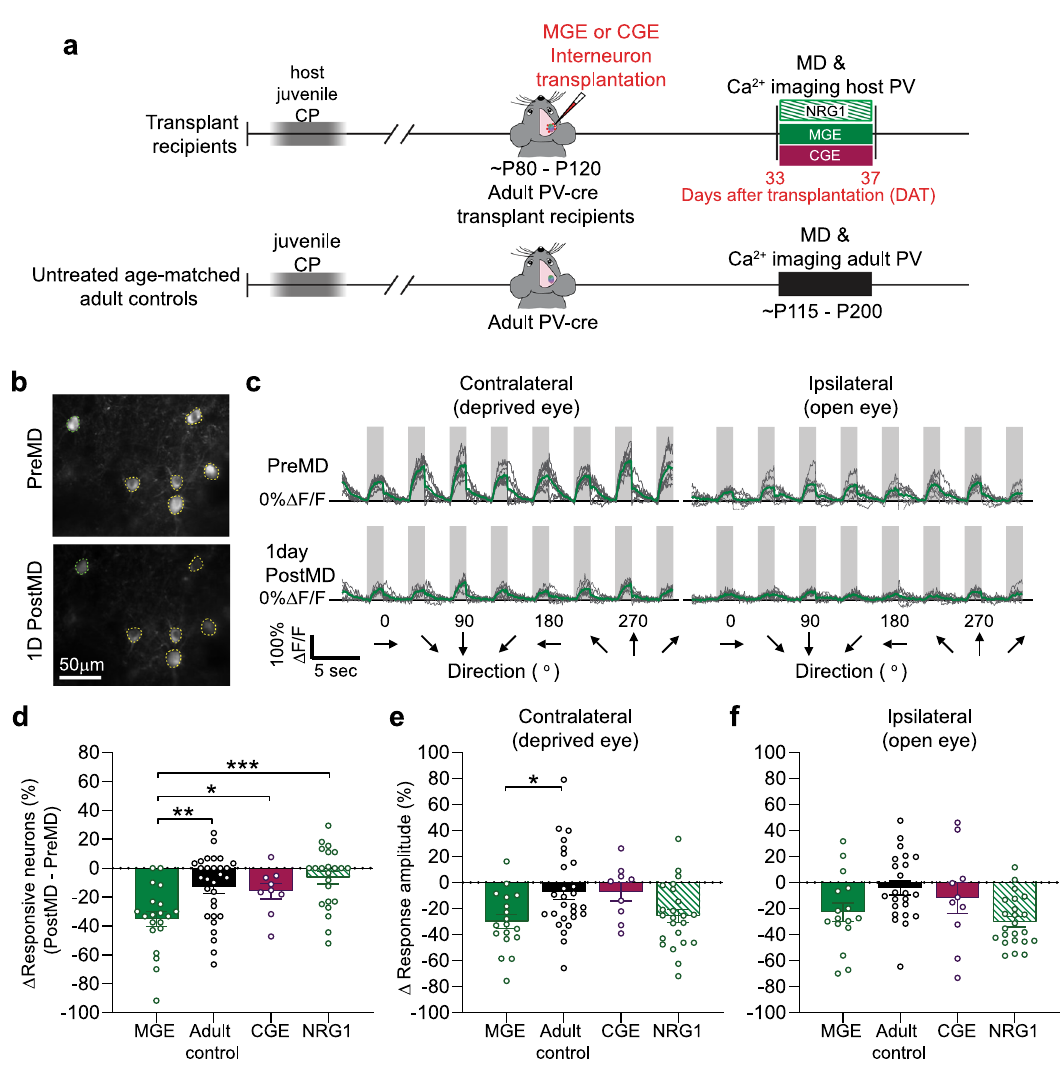
Fig. 4 Transplant-induced sensitivity of host PV interneurons to brief MD depends upon NRG1 signaling. a Experimental timeline. Top: calcium imaging of host PV interneurons in MGE transplant recipients (green, MGE), MGE recipients treated with NRG1 (dashed green, NRG1) or CGE transplant recipients (magenta, CGE) were performed at 33 – 35 days after transplantation. Bottom: imaging of PV interneurons in untreated adult control mice was performed around postnatal day (P) 115 (black, adult control). b In vivo image of GCaMP6s-labeled host PV interneurons in a MGE transplant recipient. Responsive cells are outlined in yellow and green. Scale bar = 50 µ m. In vivo Ca 2 + imaging of PV interneurons were performed independently in 25 mice (17 transplant recipients and 8 wild-type mice). c Visually evoked responses at the peak spatial frequency for the cell outlined in green in b . d 1D MD reduced the overall responsiveness of host PV interneurons in 35DAT transplant recipients (MGE: n = 20 fi elds from 6 mice; adult control: n = 30 fi elds from 8 mice; 35DAT CGE: n = 9 fi elds from 5 mice; NRG1: n = 23 fi elds from 6 mice; 35DAT MGE vs. adult control: ** p = 0.0054; 35DAT MGE vs. 35DAT CGE: * p = 0.048; 35DAT MGE vs. NRG1: *** p = 0.0004, Brown – Forsythe ANOVA followed by Dunnett ’ s T3 multiple comparisons test). e , f 1D MD resulted in a large reduction in the response amplitude of 35DAT host PV interneurons through both the deprived ( e ) and open eyes ( f ). However, exogenous NRG1 did not prevent the reduction in the response amplitude of host PV interneurons (Contra: 35DAT MGE, n = 18 fi elds from 6 mice; adult control, n = 27 fi elds from 8 mice; CGE, n = 9 fi elds from 5 mice; NRG1, n = 23 fi elds from 6 mice; 35DAT MGE vs. adult control, * p = 0.019; 35DAT MGE vs. 35DAT CGE: p = 0.056; 35DAT MGE vs. NRG1: p = 0.914; Ipsi: 35DAT MGE, n = 16 fi elds from 6 mice; adult control, n = 23 fi elds from 8 mice; CGE, n = 10 fi elds from 5 mice; NRG1, n = 23 fi elds from 8 mice; 35DAT MGE vs. adult control, p = 0.125; 35DAT MGE vs. 35DAT CGE: p = 0.819; 35DAT MGE vs. NRG1: p = 0.746, Brown – Forsythe and Welch ANOVA followed by Dunnett ’ s T3 multiple comparisons test). Data in d , e , and f are mean ±